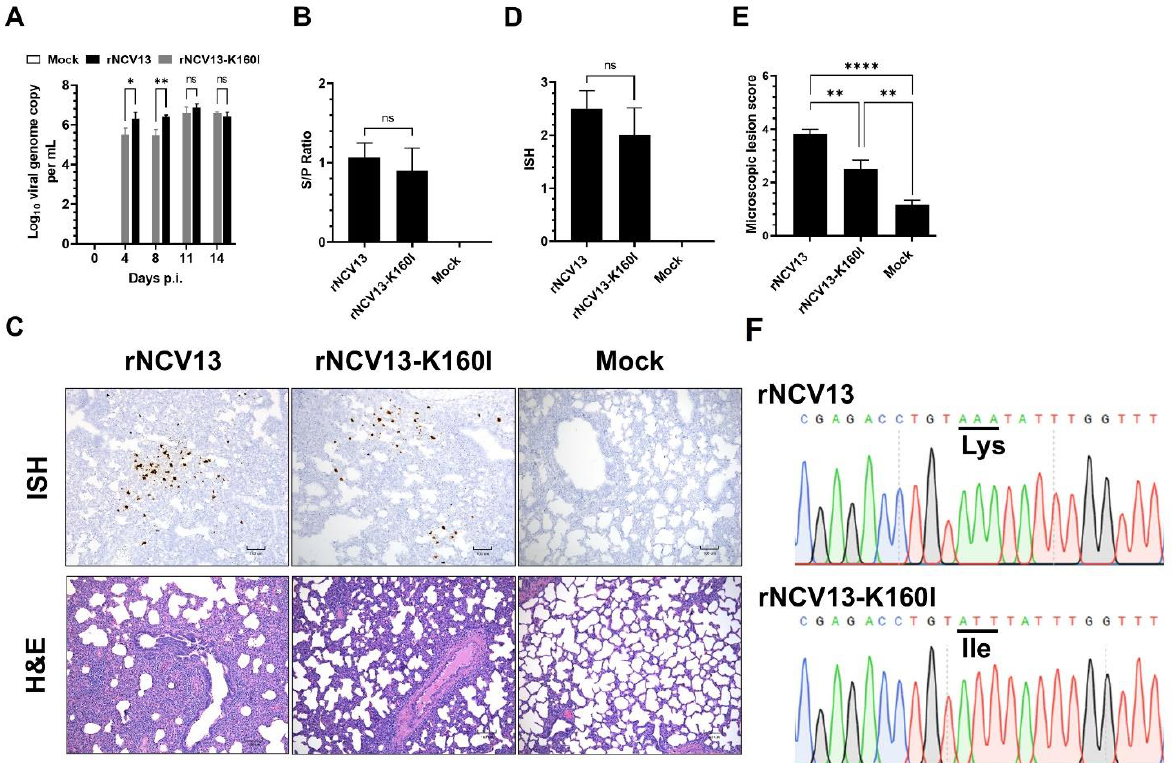
Figure 10. Experimental inoculation of pigs with the virulent PRRSV strain rNCV13 and its derived mutant rNCV13-K160I. ( A ) Viral load in serum samples measured by RT-qPCR. ( B ) Levels of serum antibody against PRRSV measured by ELISA. ( C ) Representative images of in situ hybridization (ISH) and H&E staining of lung sections collected at 14 dpi. ( D ) ISH scores of the lung sections. ( E ) Microscopic scores of the lung sections. ( F ) Representative sequencing chromatograms covering codon GP2 160 is underlined. Triplet AAA codes for lysine (Lys) and ATT codes for isoleucine (Ile). The viral genomes were extracted from the serum samples collected from pigs inoculated with rNCV13 or rNCV1-K60I viruses at 14 dpi and subjected to sequencing. Each nucleotide in the chromatogram is depicted with unique color code. ns: non-statistically significant, ** p < 0.01, **** p < 0.0001.